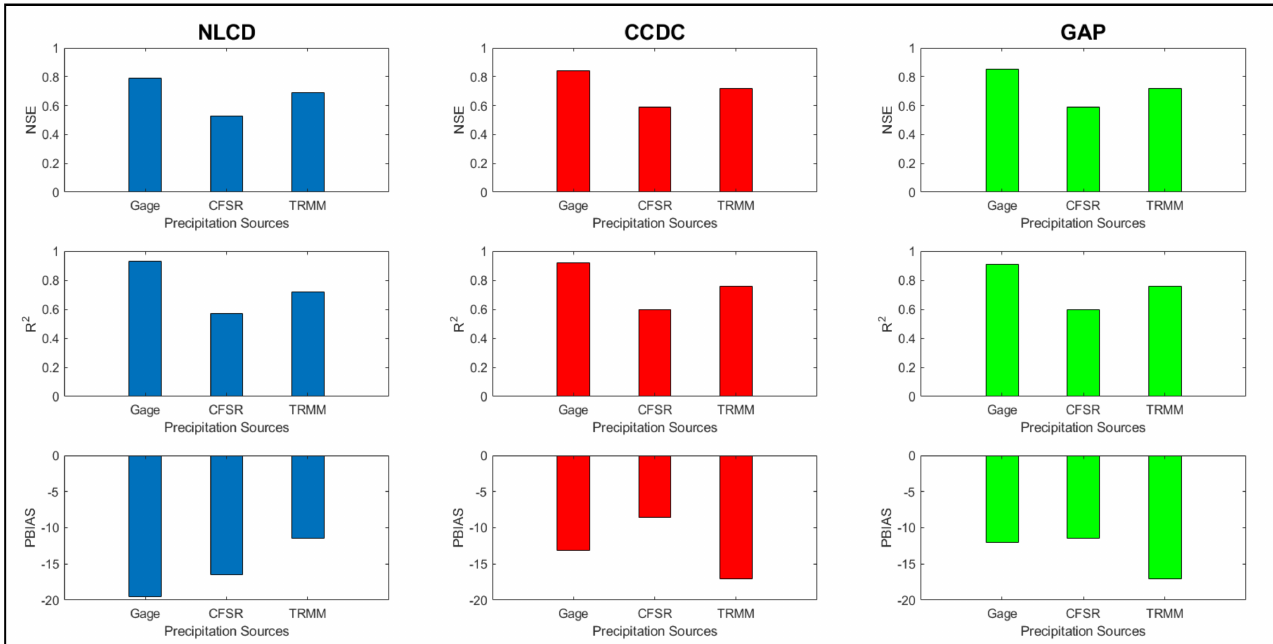
Figure 11. Model performance with various LULC and precipitation dataset combinations for the ASTER DEM based on NSE, R2, and PBIAS